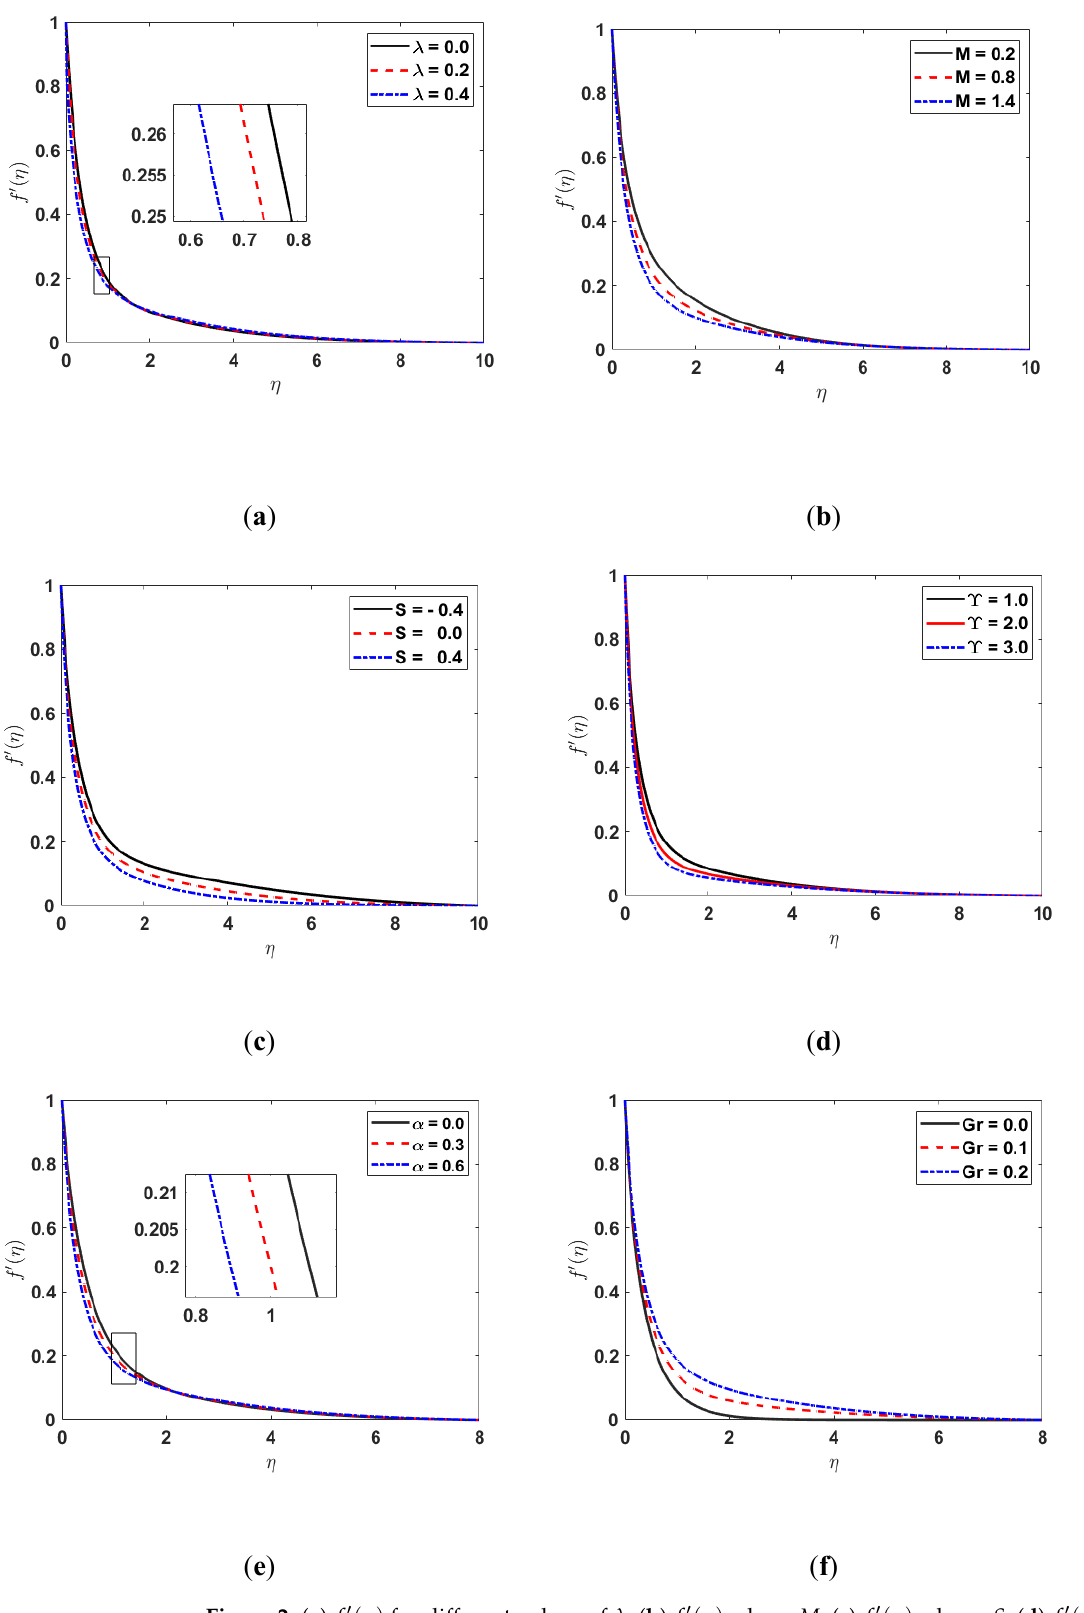
Figure 2. ( a ) f (cid:48) ( η ) for different values of λ ; ( b ) f (cid:48) ( η ) along M ; ( c ) f (cid:48) ( η ) along S ; ( d ) f (cid:48) ( η ) along